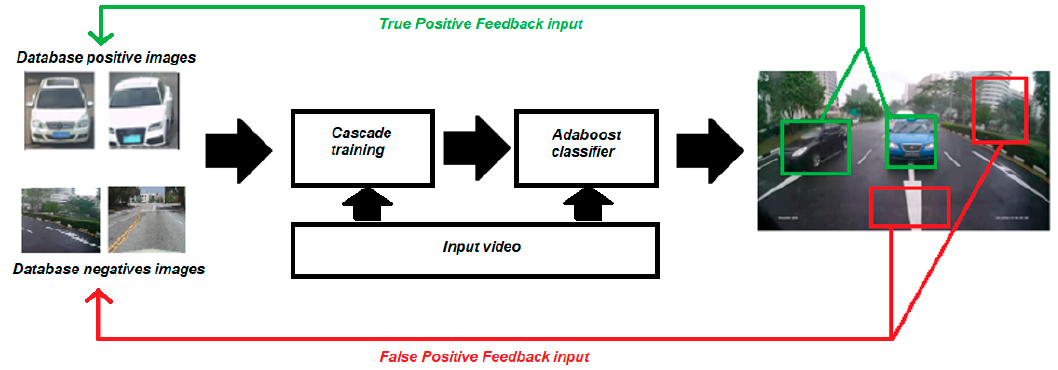
Figure 9. Feedback Adaboost system.